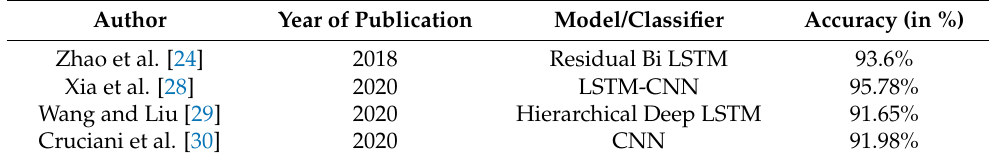
Table 3. Performance measurement of the latest HAR approaches on the UCI-HAR